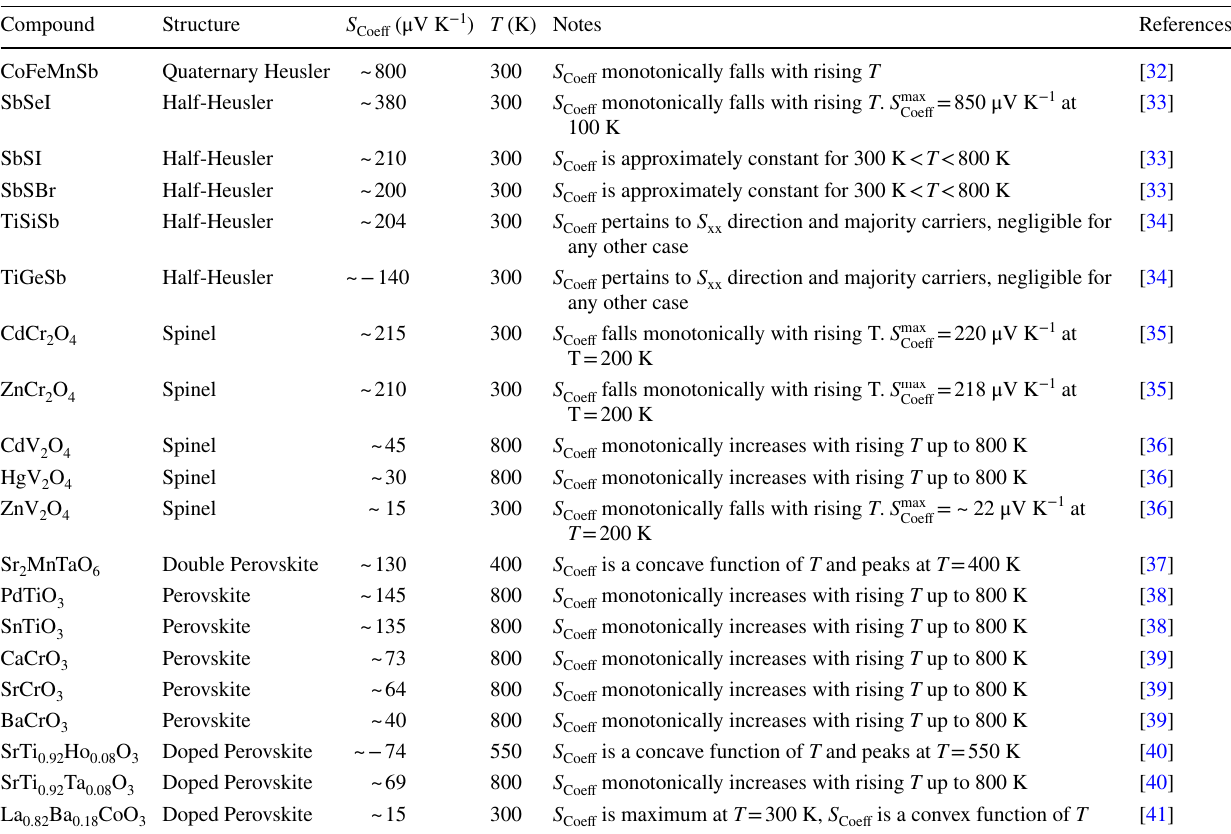
The S Coeff were reported for temperatures at which S Coeff was either maximum ( S max Coeff ) or for 300 K if S Coeff peaked below room